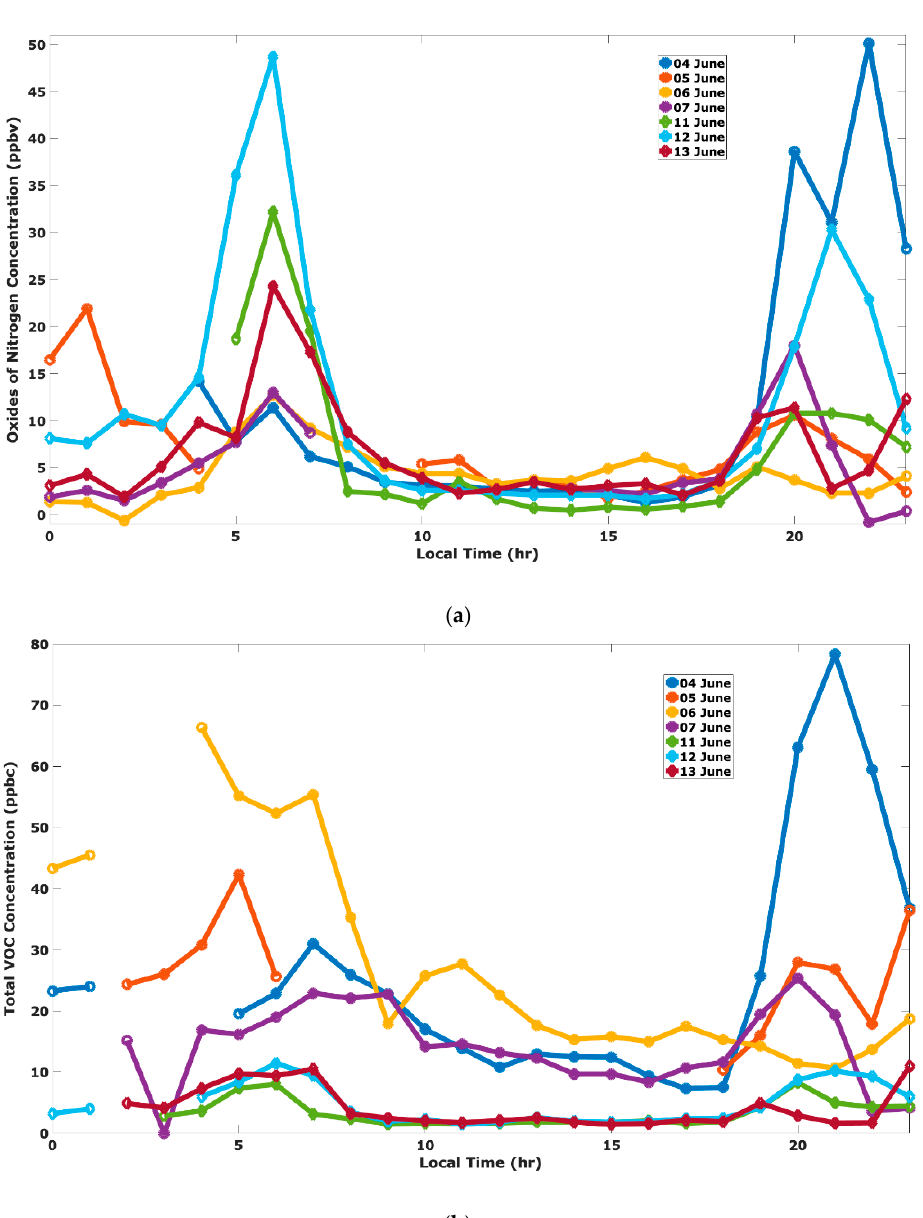
Figure 7. ( a ) The nitrogen oxides (NO x ) concentration plot, and ( b ) the total VOC concentrations for the high and low ozone episodes for the city of ELP. Data obtained from TCEQ CAMS 12 and CAMS 41, respectively.